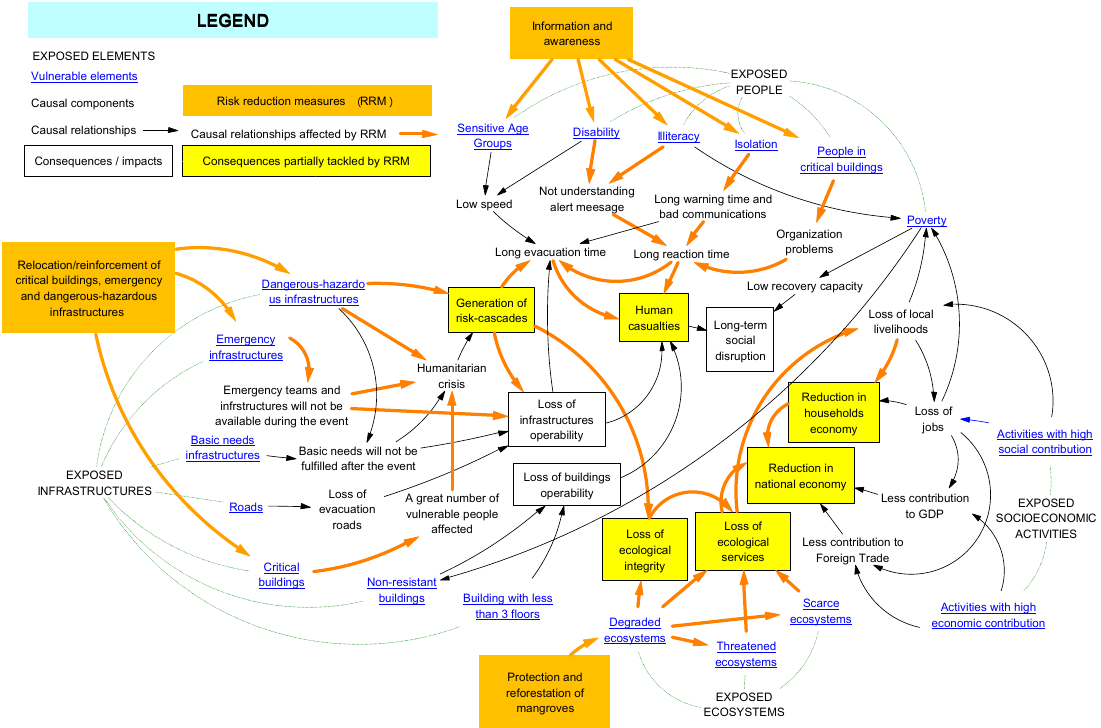
Figure 10. (a) System dynamics for the analysis of tsunami impacts in El Salvador; (b) causal relationships and tsunami impacts affected by potential risk reduction measures (Vensim ®